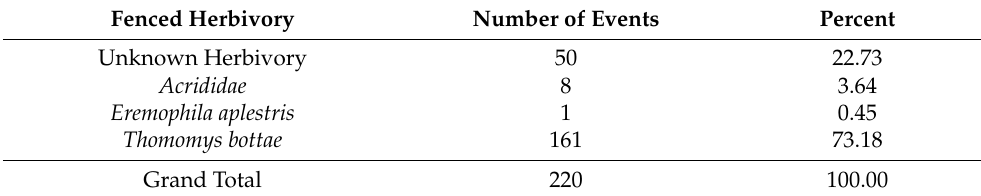
Table 5. Frequency of herbivory events on seedlings in fenced